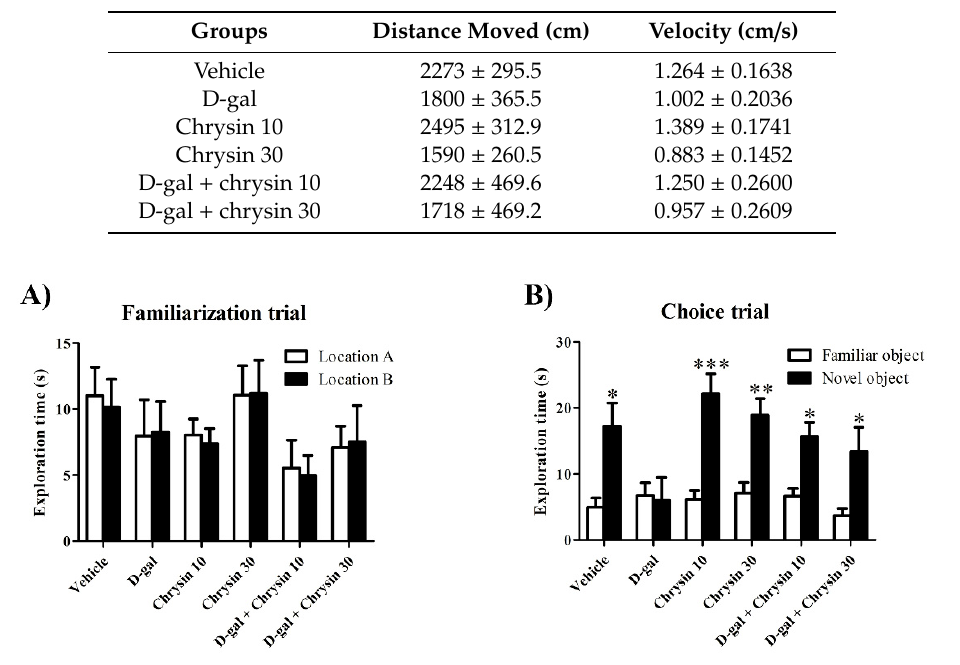
Table 2. Distance moved and velocity (mean ± SEM) in the novel object recognition (NOR) test.